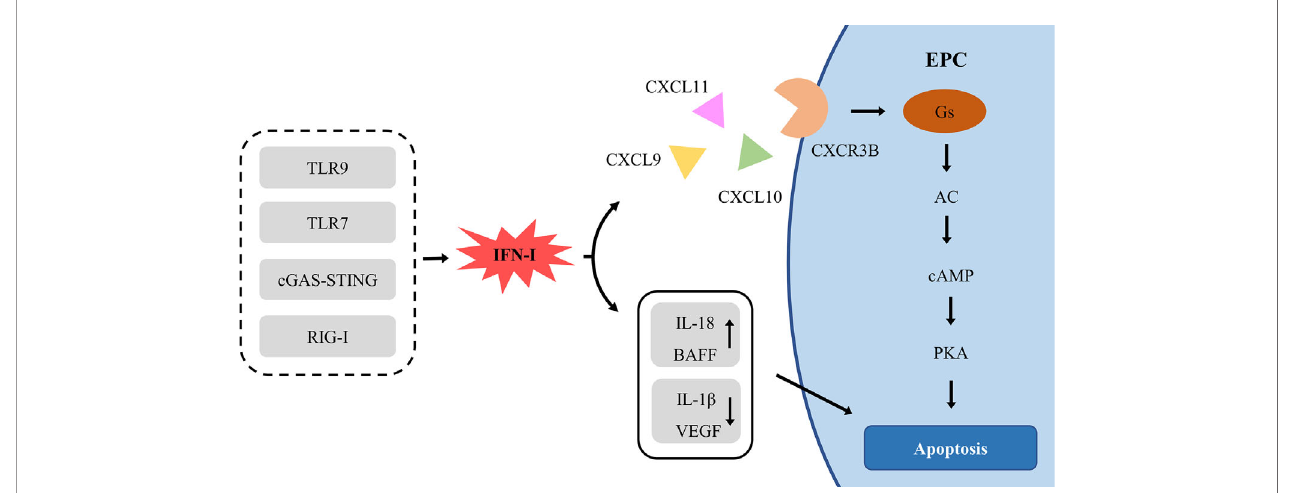
FIGURE 4 | The signal pathway of IFN-Idamaging EPC. AC, adenylyl cyclase; BAFF, B cell-activating factor; cAMP, cyclic adenosine monophosphate; cGAS, cyclic guanosine monophosphate (GMP)-adenosine monophosphate (AMP) synthase; CXCL, chemokine (C-X-C Motif) ligand; CXCR, chemokine (C-X-C motif) receptor; EPC, endothelial progenitor cell; PKA, Protein kinase A; RIG-I, retinoic acid-inducible gene I; TLR, Toll-like receptor; VEGF, vascular endothelial growth